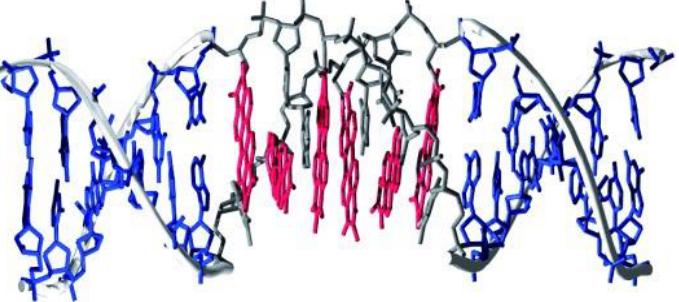
Figure 7. Minimized geometry of DNA duplex with the PDI hexamers drawn in red [75]. Copyright © 2008, WILEY-VCH Verlag GmbH & Co. KGaA,